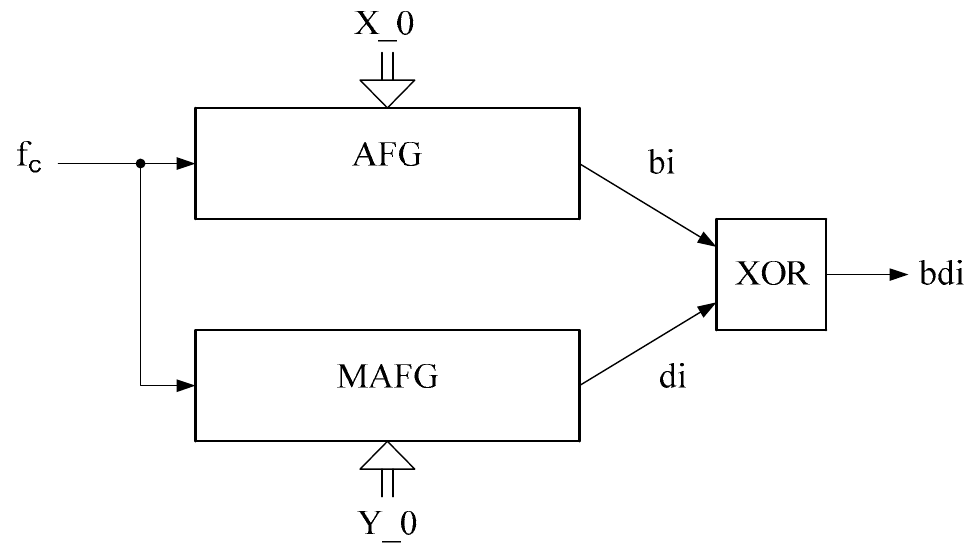
Structure Scheme of the Joint Work of AFG and MAFG and the Principle of Its Work The generalized scheme of joint work of AFG and MAFG is given in Figure 1, and the corresponding detailed structure scheme is given in Figure 2.